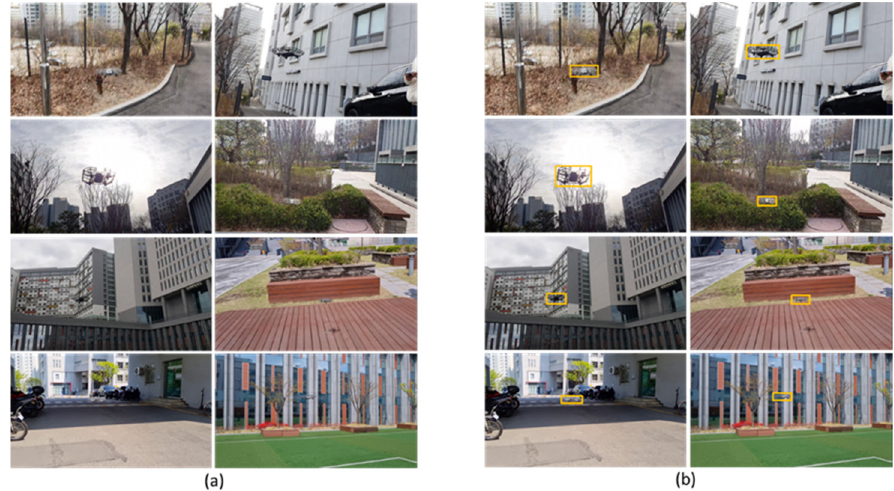
Figure 3. Dataset samples of flying MAV in various backgrounds. ( a ) original images, and ( b ) same images with annotated bounding boxes of the MAV.